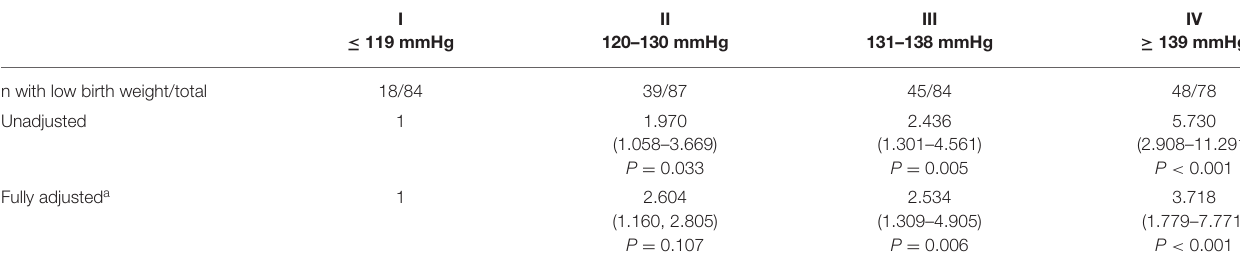
TABLE 4 | Association of prenatal first SBP and low birth weight.